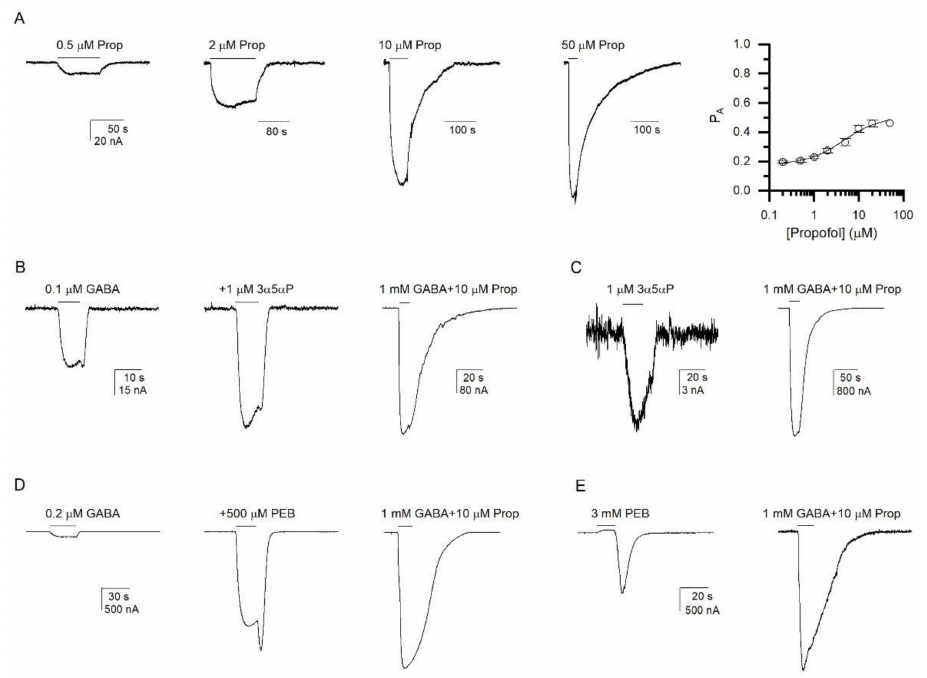
Figure 3. Activation and potentiation of the α 1 β 2 ε GABA A receptor by allosteric agonists. ( A ) Sample current responses to 0.5, 2, 10, and 50 µ M propofol (Prop). All traces are from the same cell. The right panel gives the propofol concentration-response relationship. The data are ex- pressed in the units of P A . The data points give means ± S.D. from five cells. The curve is calculated using the mean K R,propofol (4.1 µ M) and c propofol (0.771) values with the number of propofol binding sites constrained to 6. ( B ) Sample current responses to 0.1 µ M GABA and 0.1 µ M GABA + 1 µ M 3 α 5 α P. For comparison, a response to 1 mM GABA + 10 µ M propofol (Prop) is given. All traces are from the same cell. ( C ) Sample current responses to 1 µ M 3 α 5 α P and 1 mM GABA + 10 µ M propofol (Prop), from the same cell. ( D ) Sample current responses to 0.2 µ M GABA and 0.2 µ M GABA + 500 µ M pentobarbital (PEB). For comparison, a response to 1 mM GABA + 10 µ M propofol (Prop) is given. All traces are from the same cell. The amplitude of rebound current upon washout of GABA + PEB was used for analysis. ( E ) Sample current responses to 3 mM pentobarbital (PEB) and 1 mM GABA + 10 µ M propofol (Prop), from the same cell. The amplitude of rebound current upon washout of PEB was used for